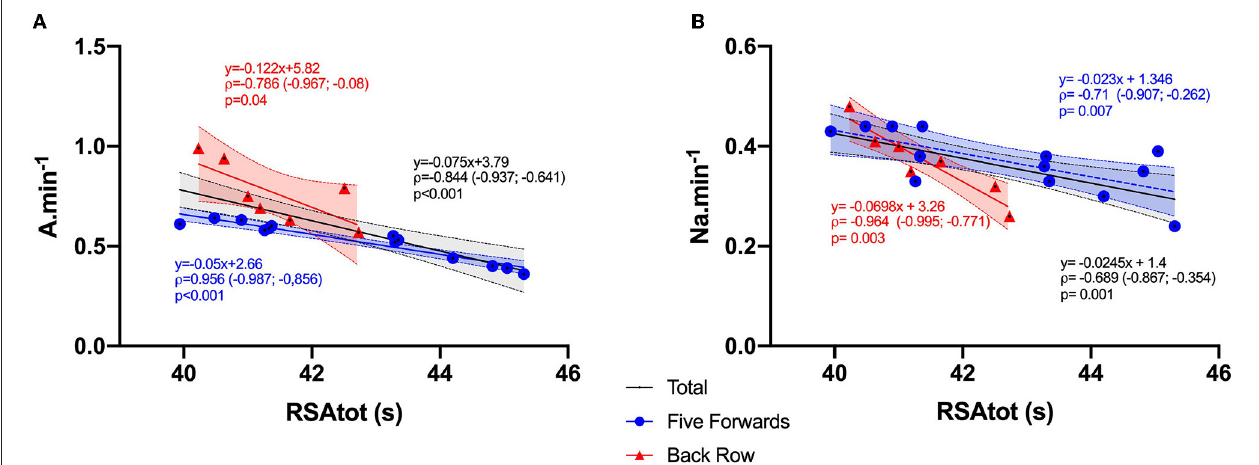
FIGURE 1 | Relationships between physical abilities and player movement characteristics in game in forwards: (A) Relationships between RSA tot and acceleration number per minute (A · min − 1 ) in forwards; (B) Relationships between RSA tot and combat action number per minute (Na · min − 1 ) in